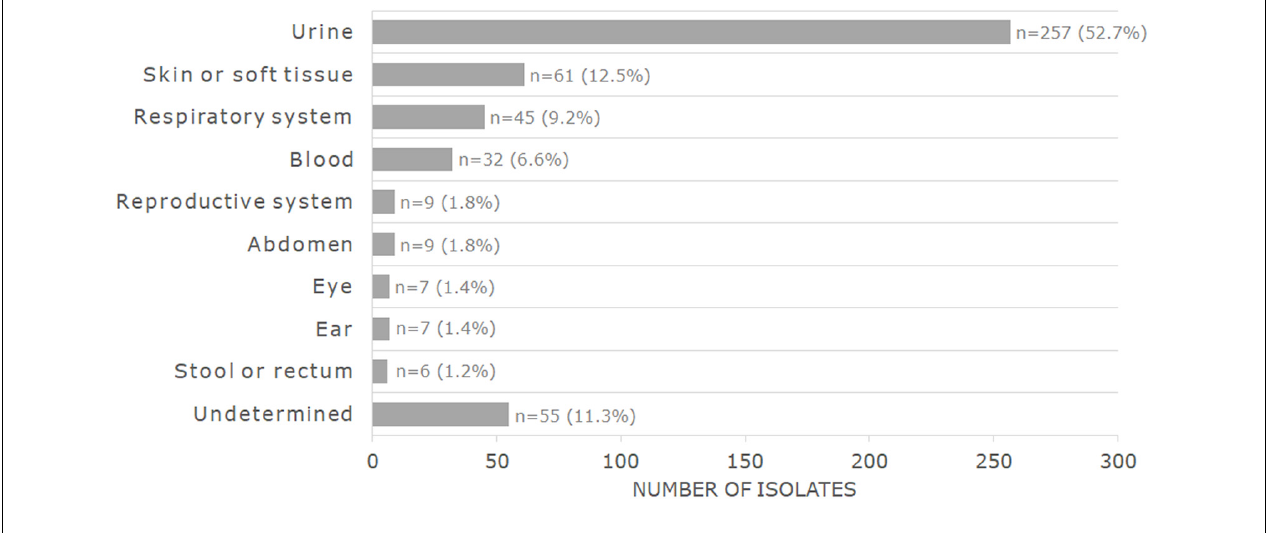
of quinupristin/dalfopristin results), with one resistant isolate missing dalfopristin resistance genes and one susceptible (I) isolate harboring quinupristin and dalfopristin resistance